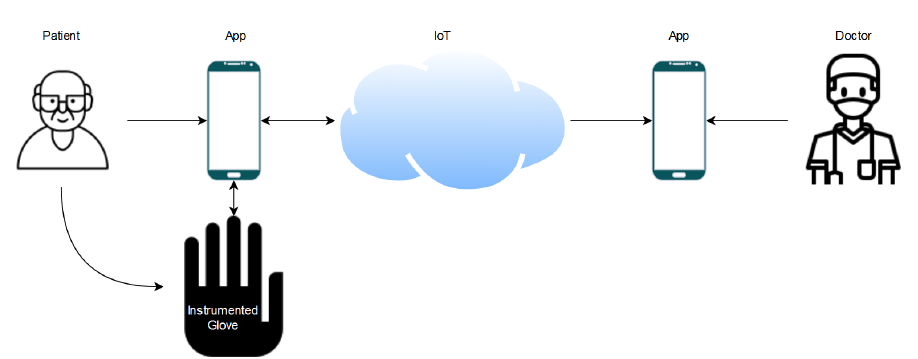
Figure 1. System